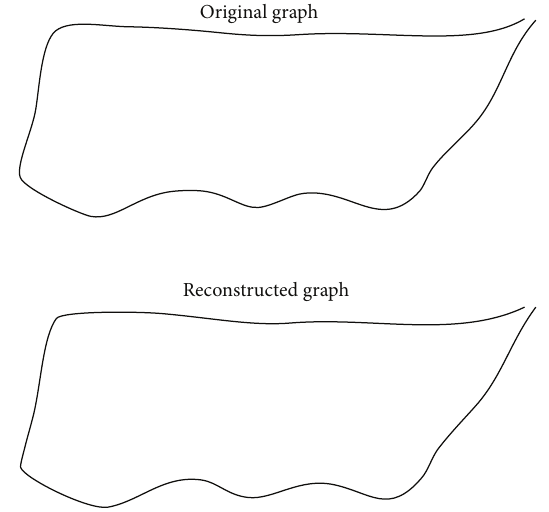
Figure 1: Result of indicator card feature extraction.